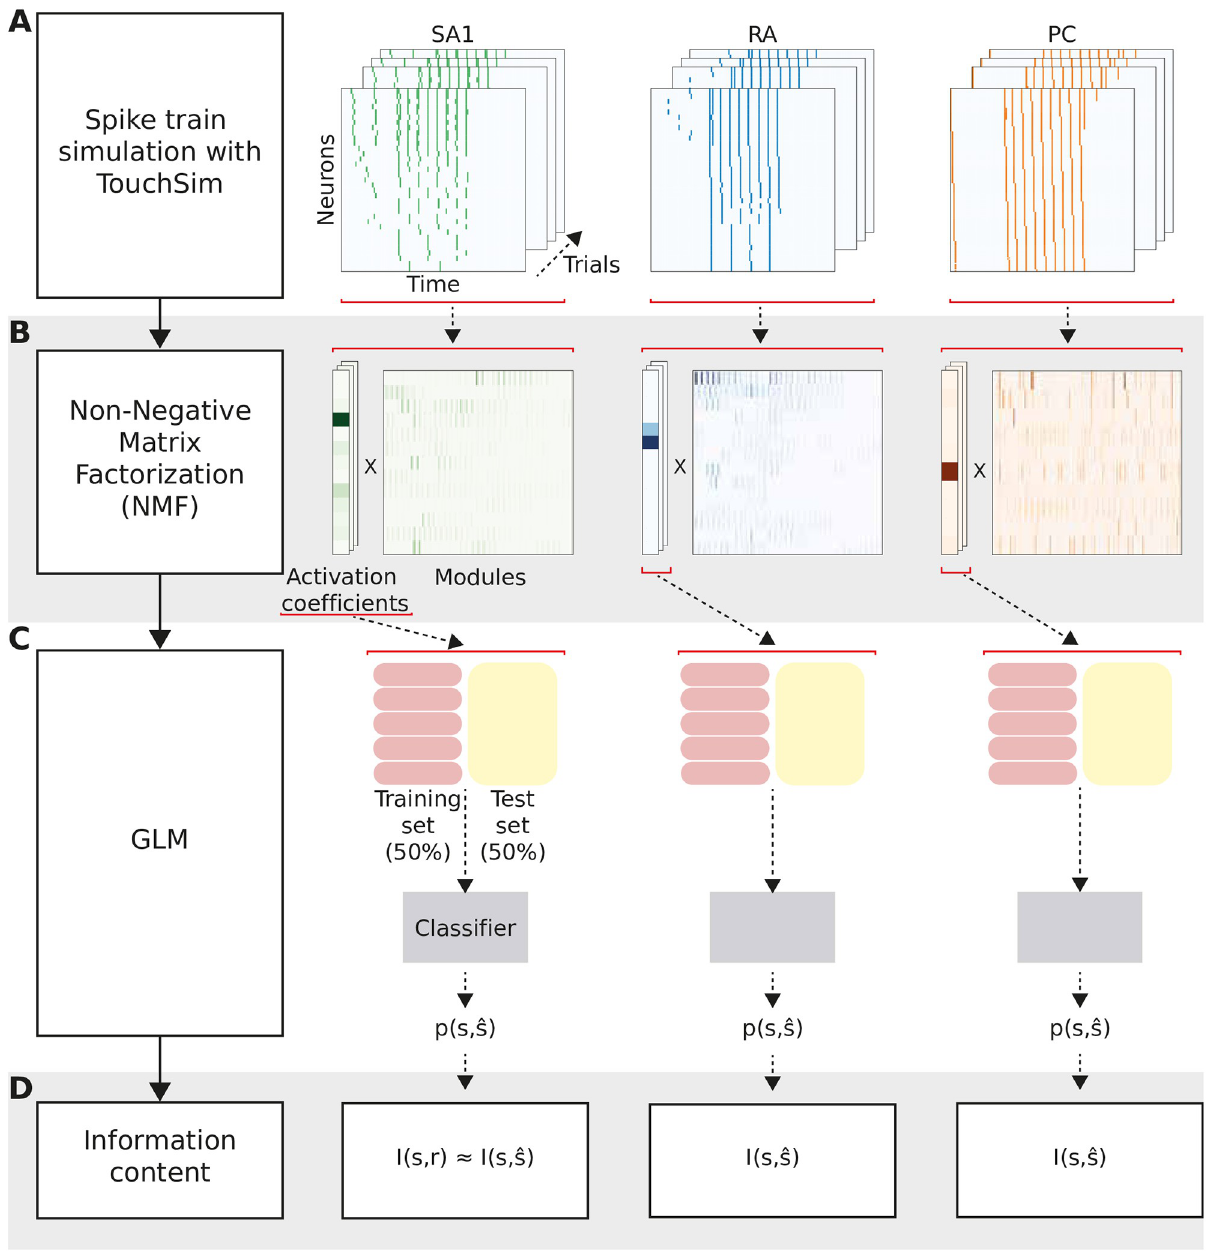
Fig 2. Analysis pipeline and calculation of information. (A) Spike trains are generated using the Touchsim simulator. (B) The spike matrices are then decomposed using the Non-Negative Matrix Factorization (NMF) method, obtaining a set of non-negative activation coefficients and modules. (C) A Generalized Linear Model (GLM) fed with the neural activity captured in the NMF activation coefficients gives the probability of observing each stimulus feature. (D) Probabilities are used to compute mutual information (MI), representing the information that the neural activity carries about the